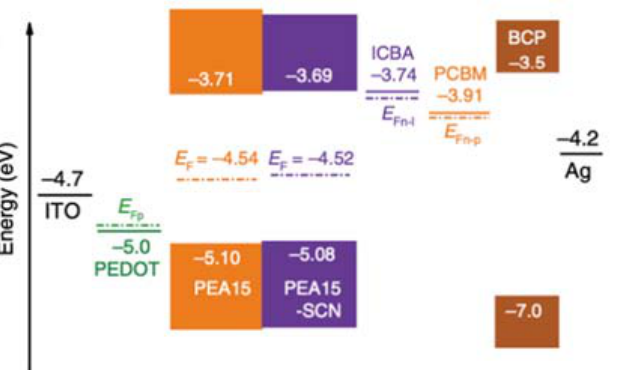
Figure 6 . Schematic illustration of energy levels with dashed lines representing the quasi-Fermi level of ICBA (E Fn–I ), phenyl-C61-butyric acid methyl ester (PCBM) (E Fn–P ), and PEDOT:PSS (E Fp ). Reprinted with permission from ref. [50]. Copyright 2020, the Nature Publishing Group.